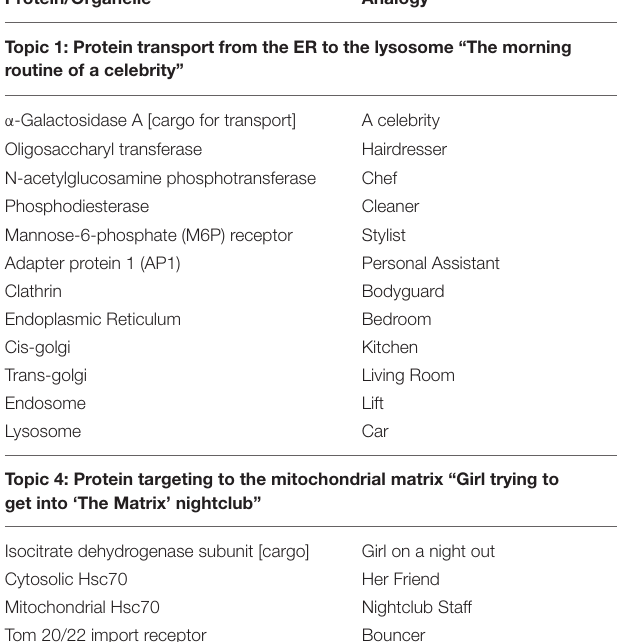
FIGURE 1 | Examples of role-plays that used narrated animation and drawing to explain the assigned cellular process. One group used stop–go animation with shapes made from modeling clay to illustrate protein targeting to the ER (A) , while another employed drawing on a white board to describe receptor-mediated endocytosis of low density lipoprotein (LDL) particles (B) . Both role-plays used voice-over narration to explain the processes.